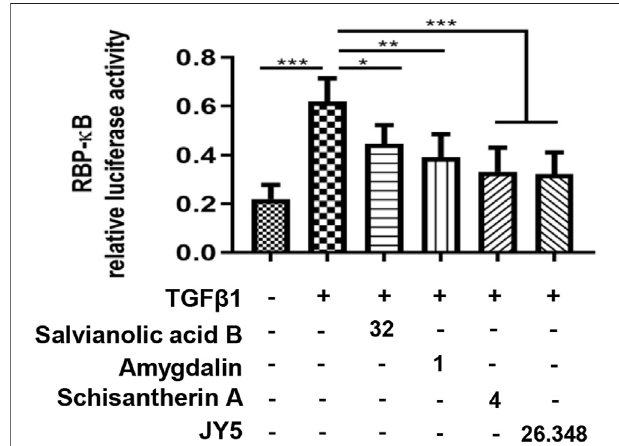
FIGURE 9 | RBP- l B luciferase reporter activity. RBP- l B luciferase reporter activity in LX-2 cells after 24 h treatment with salvianolic acid